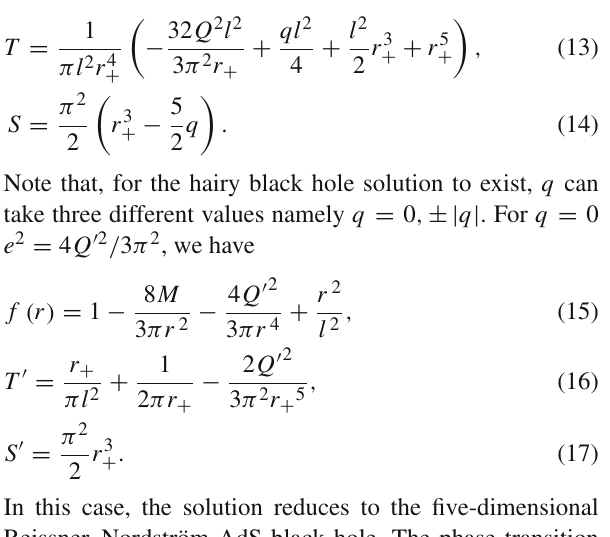
Table 1 The critical values of the electric charge, temperature and entropy for different q q Q C T